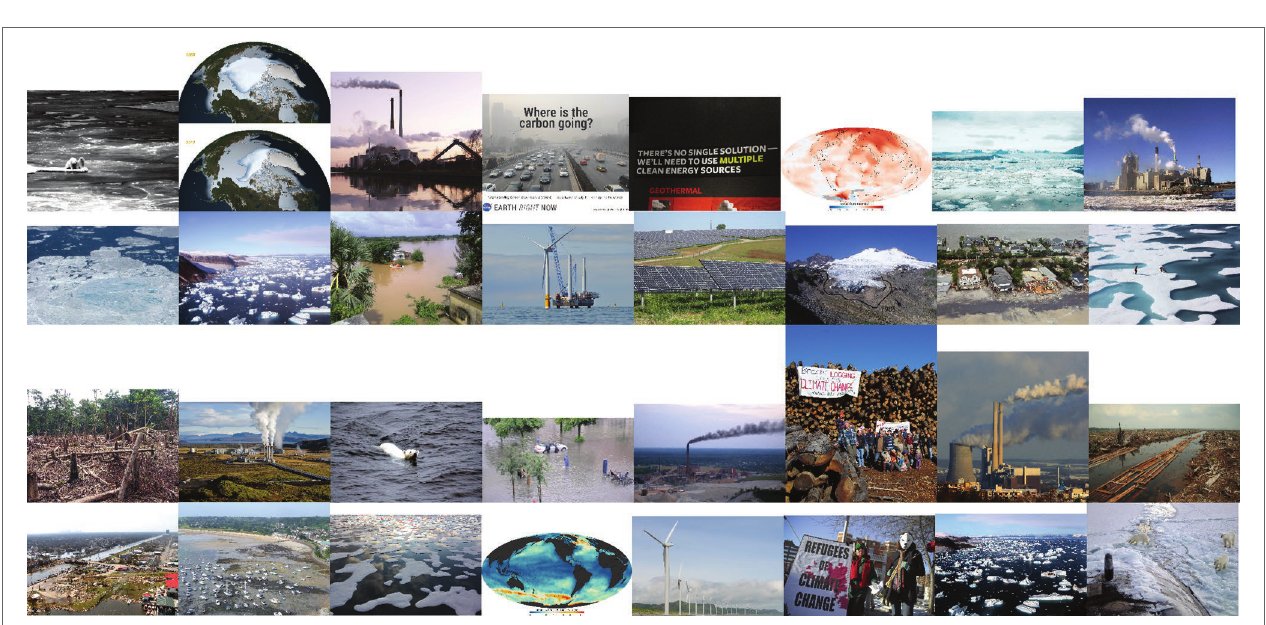
FIGURE 3 | The 32 images rated highest in relevance to climate change, read from top left to bottom